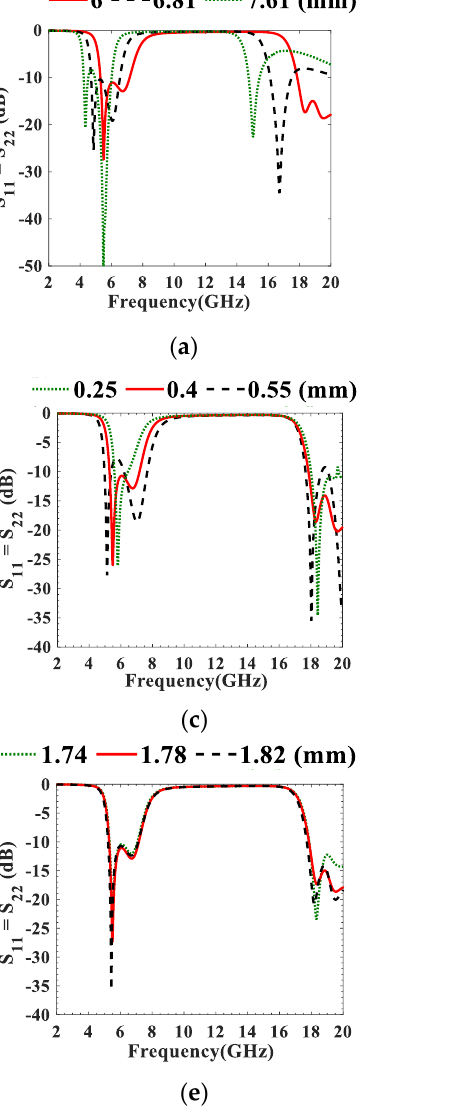
Table 2. Optimized Fourier coefficients for λ/4 NTL IBPF’s resonators at (3.7 – 4.2 GHz)